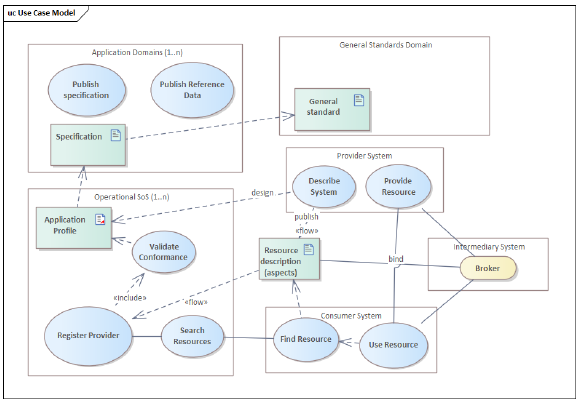
Figure 8. Typical functions for specific system